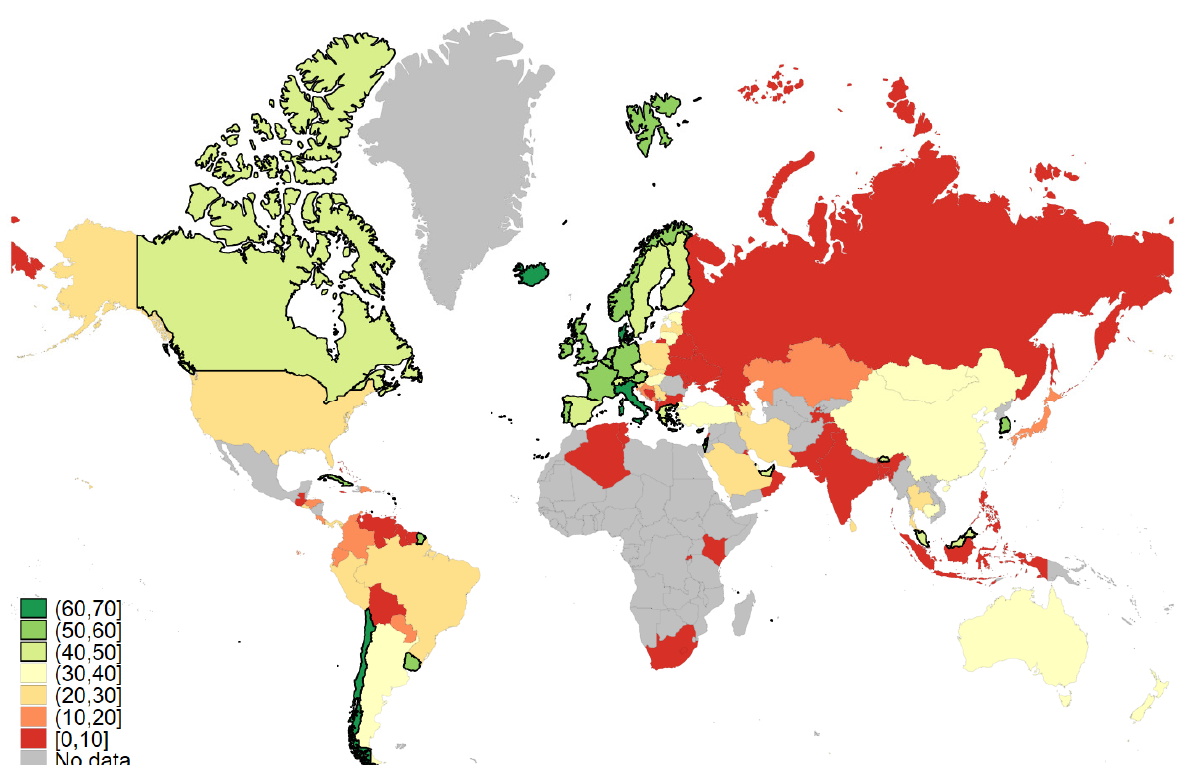
Figure 1. COVID-19 vaccine boosters administered per 100 people. Note: Data retrieved from Our World in Data , 14 February 2022.